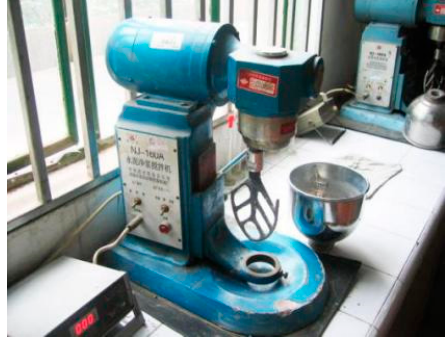
Figure 4. The electric mixer of cement paste.